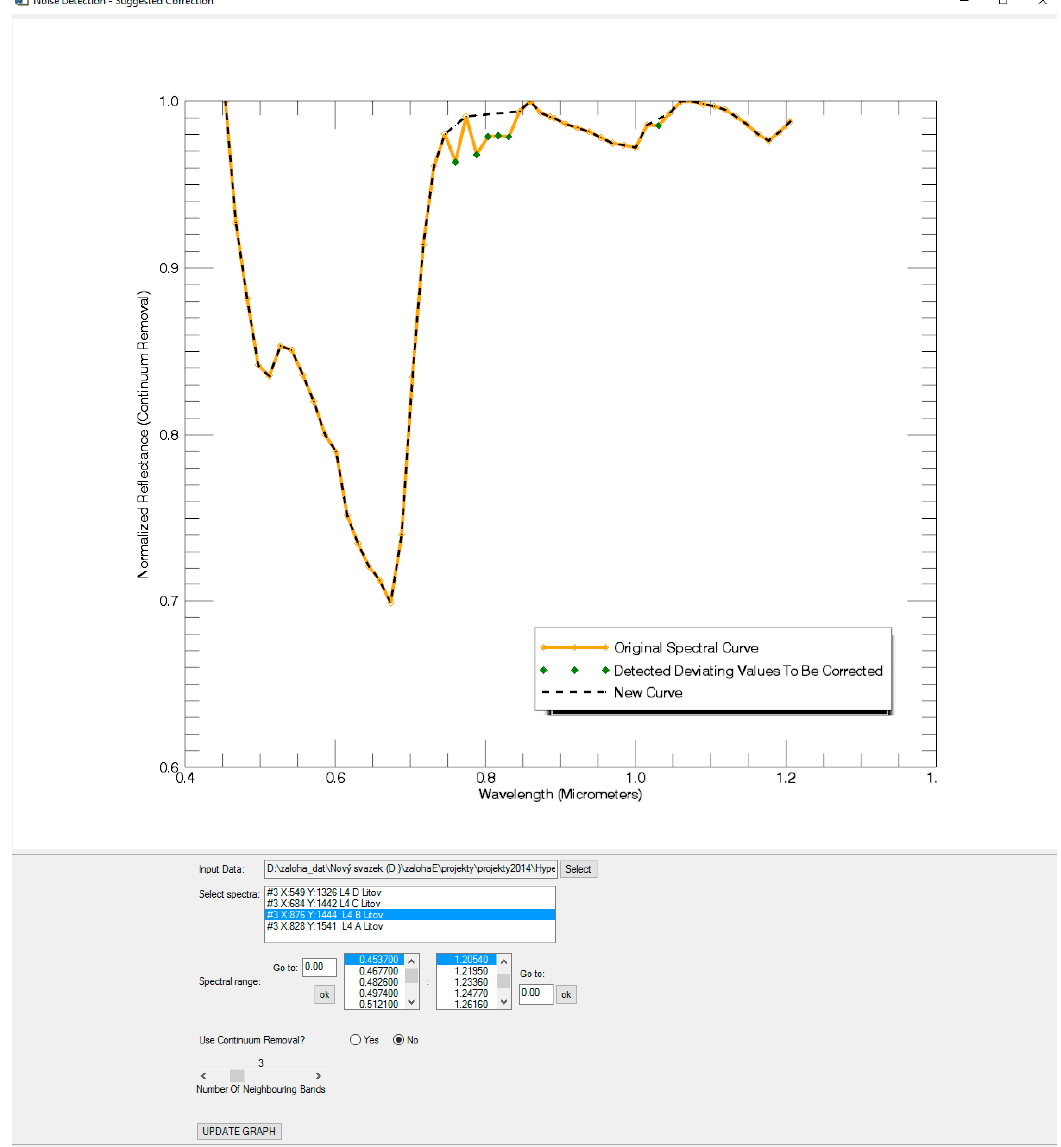
Figure 3. Bad band detection (spectral range 0.450–1.200 µm) in QuanTools where the bad bands detected are shown by the green square points and the corrected curve as a dashed line (set spectral window: three neighbouring bands).